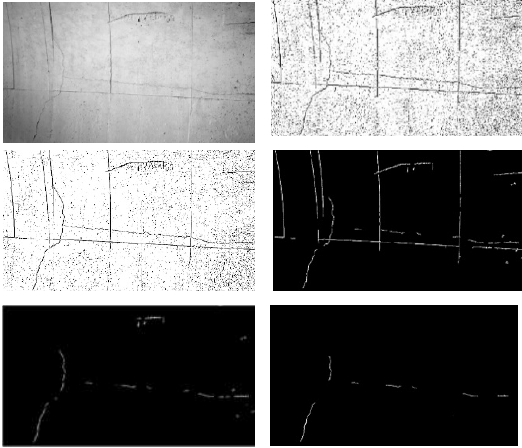
Figure 2. Illustration of the image processing step. Top : the initial image and the enhanced lines binary version; second row : noise removal and area filtering; last row : removal of the straight lines and final estimated annotations.